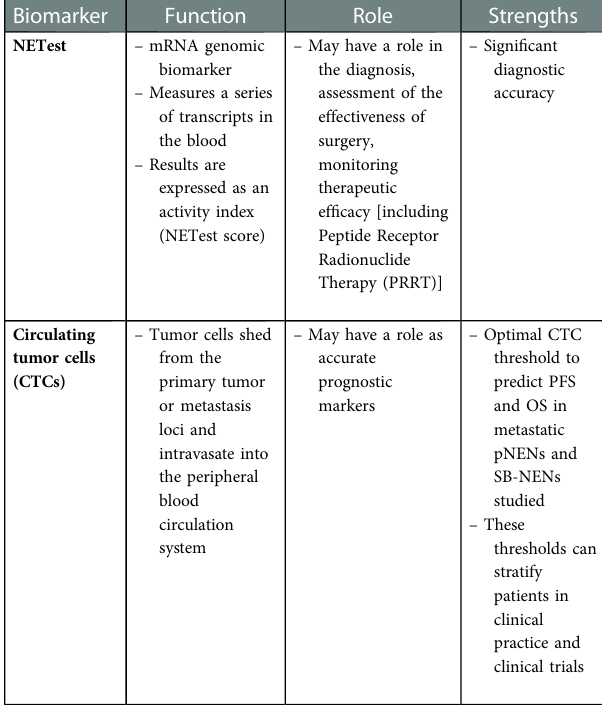
TABLE 4 Novel biomarkers for the diagnosis of neuroendocrine neoplasms (NENs).